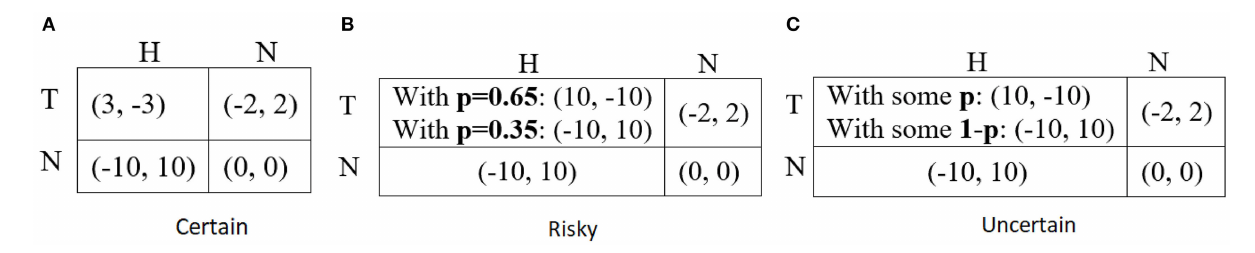
Frontiers in Psychology |